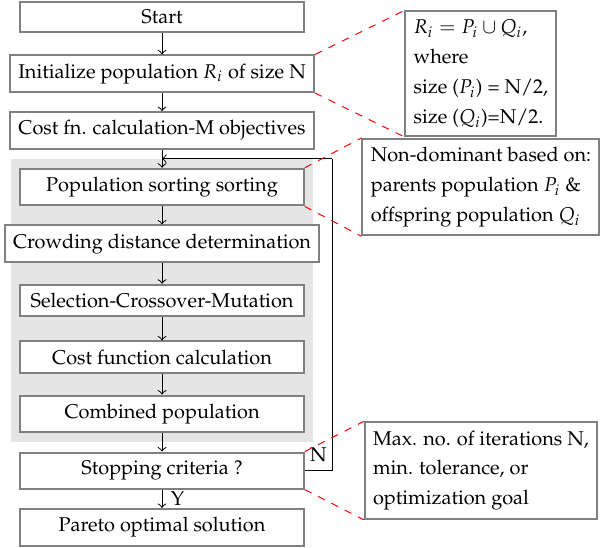
Figure 6. Illustration of multi-objective optimization steps using